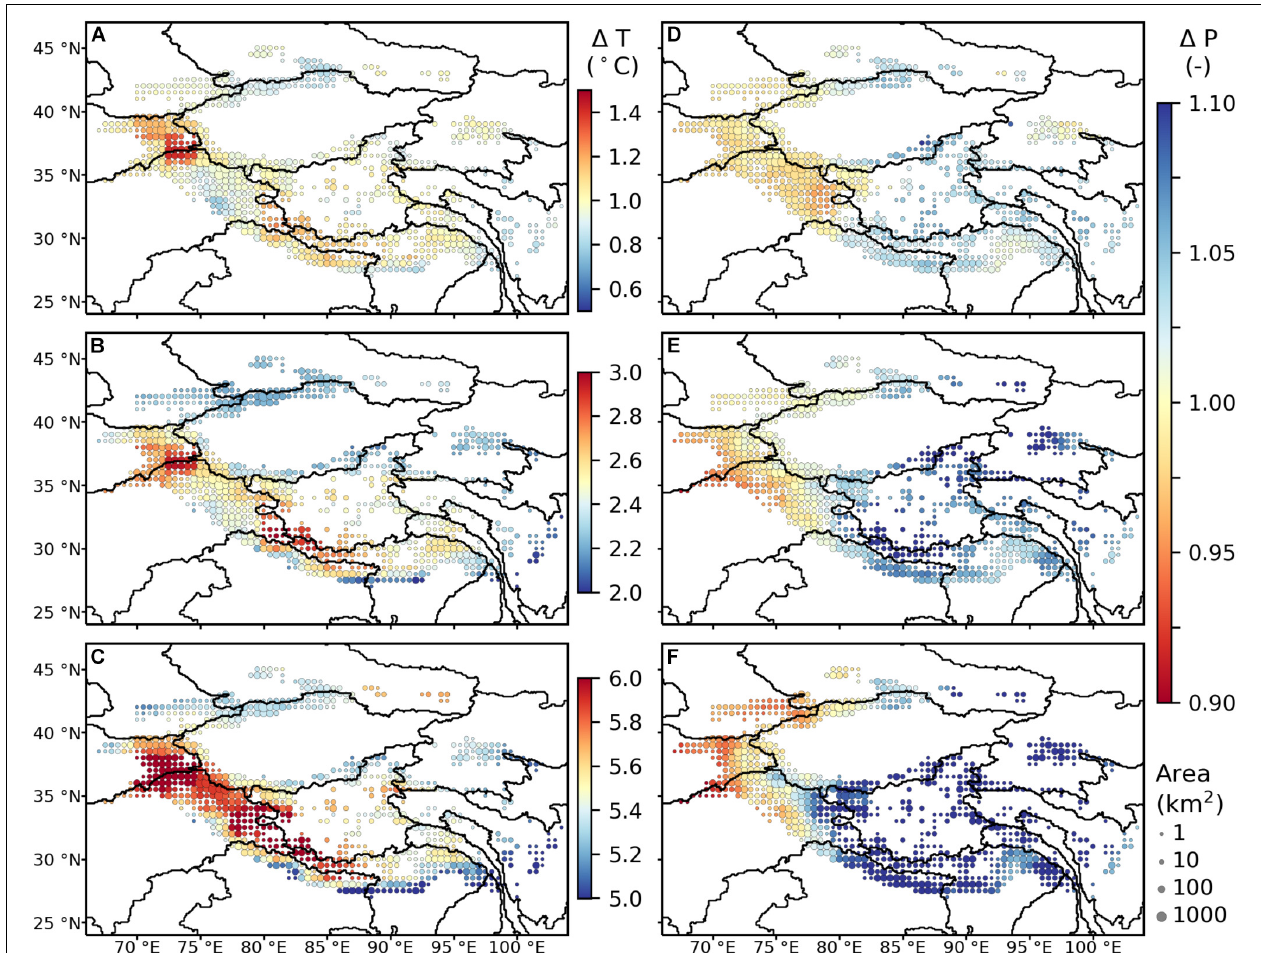
FIGURE 5 | Spatial distribution of bias adjusted (see Section 2.2), multi-GCM mean temperature change ( (cid:49) T) (A–C) and precipitation change ( (cid:49) P) (D–F) from 2085–2100, relative to 2000–2015, aggregated by 0.5 ◦ grid cells for (A,D) RCP 2.6, (B,E) RCP 4.5, and (C,F) RCP 8.5. Note the difference in the colorbar scales for the temperature change subplots. The circles are scaled by the initial glacier area (km 2 ) within the cell. Outlines of major river basins are shown for reference.